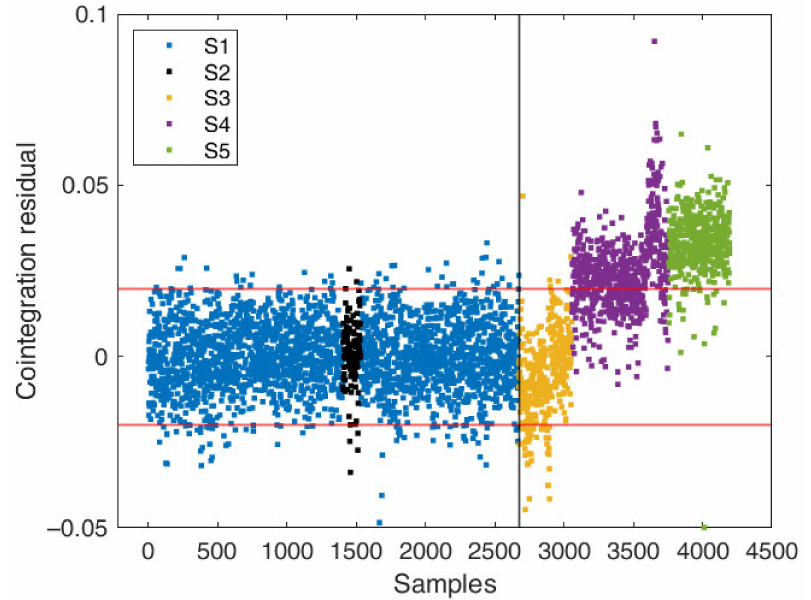
Figure 7. Control chart of cointegration residual from model f 2 = h ( f 1 , f 3 , f 4 ) . The upper and lower red lines represent the training residual mean plus or minus two times the standard